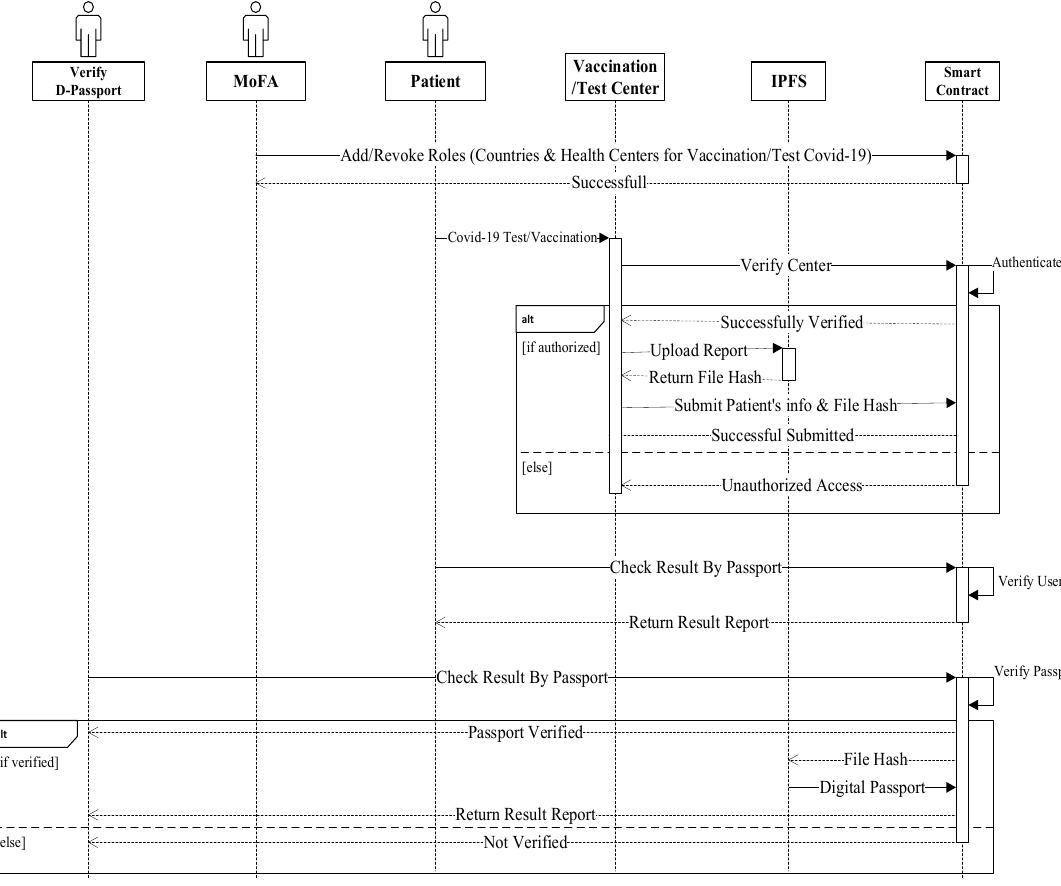
Figure 8. sequence process for digital passport.